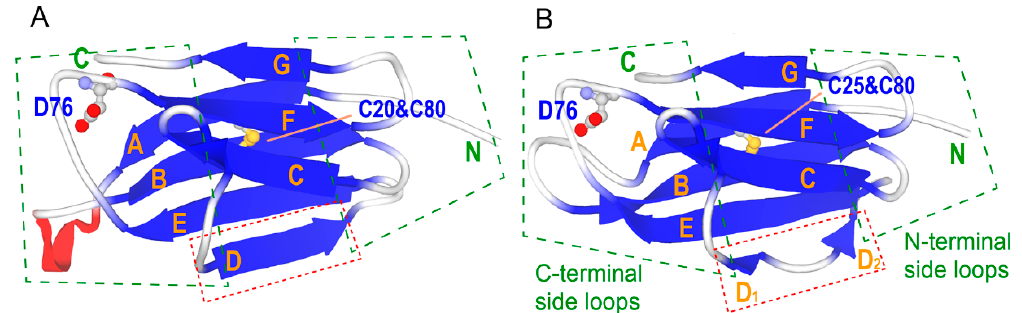
Figure 1. Crystal structures of β 2 m in an isolated monomer ( A , Protein Data Bank (PDB) ID: 2yxf [8]) and in the major histocompatibility antigen (MHC) class I complex ( B , PDB ID: 1hsb [9]). The broken green boxes indicate the N- and C-terminal side loop regions. The broken red boxes indicate the D-strand, which shows a prominent polymorphism. The side chains of D76, C25, and C80 are depicted as balls and sticks.